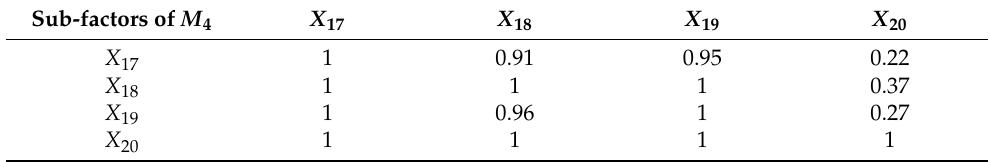
Table 11. Judgment matrix of the sub-factor layer to the upper factor M 4 .